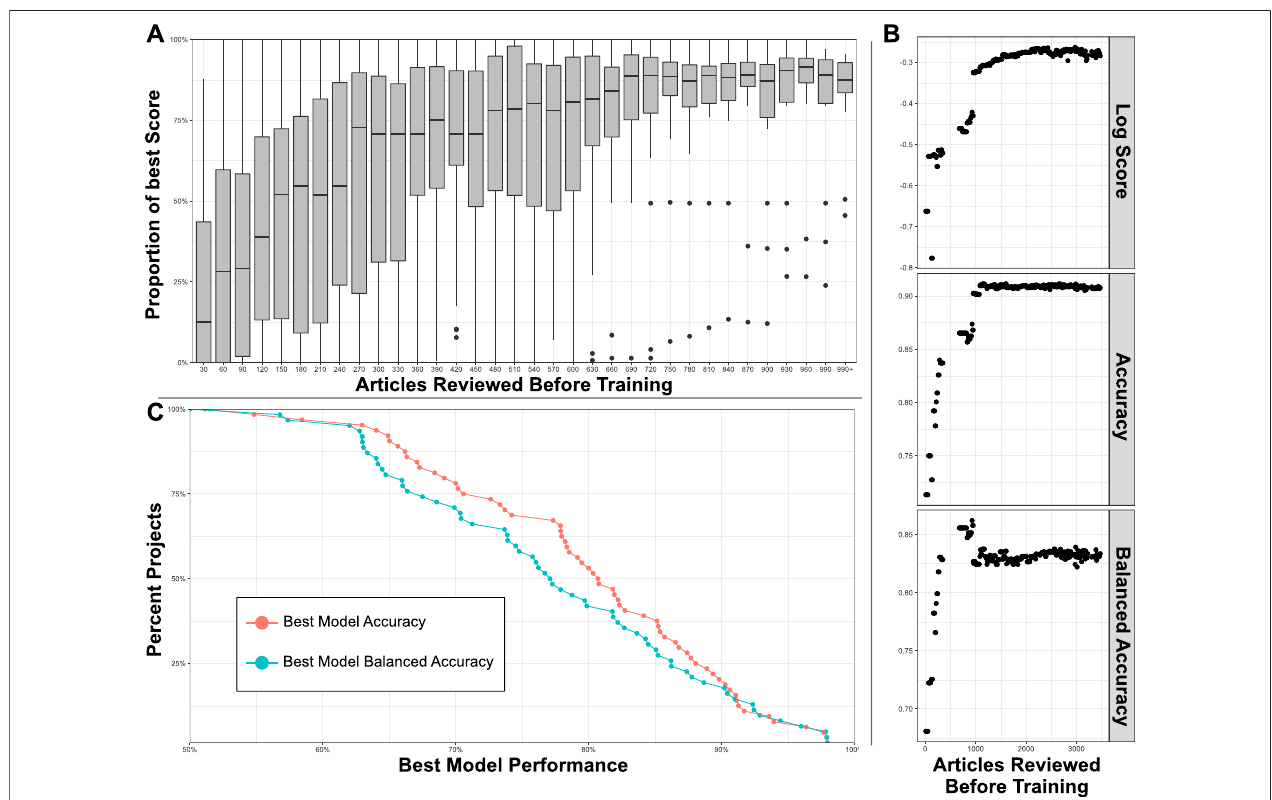
FIGURE7|(A )Boxplotsindicatedistributionofmodelperformancerelativetotheworstandbestmodelinagivenmodel ’ sproject.Modelsarebucketedaccording to the number of articles labeled before model training. Models improve rapidly until 300 articles have been reviewed. (B) Accuracy metrics for a large sysrev reviewing insect population changes. Model performance is charted as a function of number of articles used in training, across 3 performance metrics, and evaluated on a consistent holdout set. (C) Best model accuracy and balanced accuracy evaluated in 64